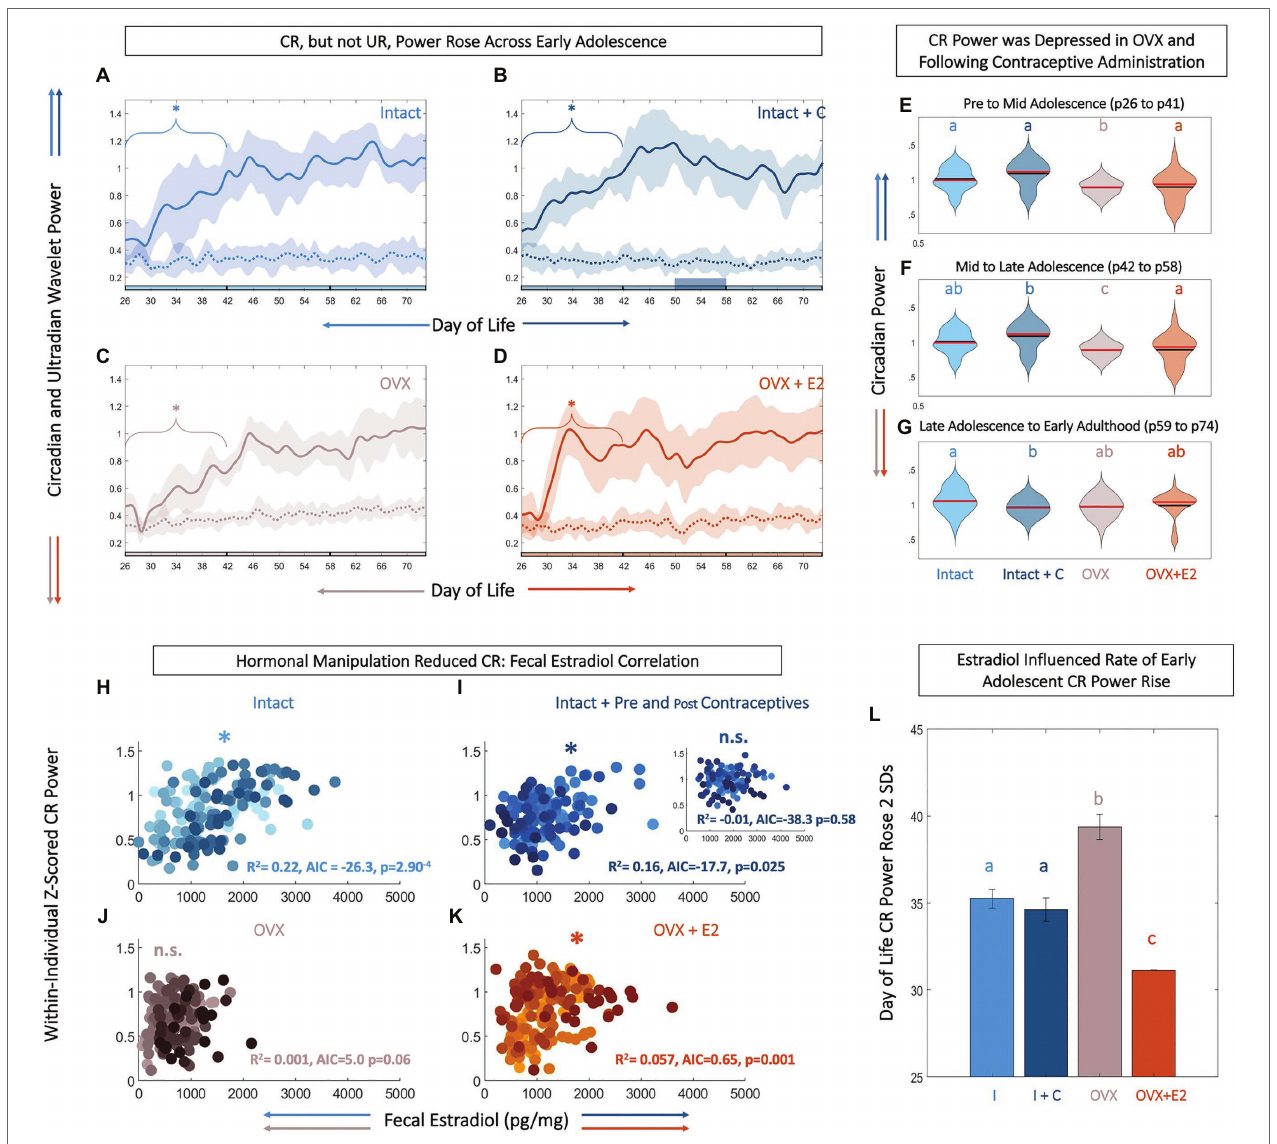
FIGURE 2 | Level and rate of early adolescent rise in core body temperature (CBT) circadian power are tied to fecal estradiol (fE2). Circadian, but not ultradian power rises across early adolescence (A-D) . Linear plots of group mean (±SD) of CBT circadian (solid) and ultradian (dashed) power in Intact (light blue, A ), Intact + C (dark blue, B ), OVX (gray, C ), and OVX + E2 (orange, D ) animals. * indicates significant trend over time for the bracketed time region ( p < 0.05). Phase of adolescent time periods (pre to mid, mid to late, and late to adult) are indicated by black dividers in the colored x-axis at p42 and p58. Although, CBT circadian power rises over early adolescence in all groups, estradiol increases the rate of this rise (L) . Violin plots (E–G) of circadian power in each group analyzed by segment of life: pre to mid adolescence from p26 to p41 (E) , mid to late adolescence from p42 to p57 (F) , and late adolescence through early adulthood from p58 to p73 (G) illustrate that circadian rhythm (CR) power is highest in Intact animals, with a reduction following hormonal contraceptive administration and OVX, and a partial rescue in OVX + E2 animals. Black lines indicate mean and red lines indicate median of each plot. Scatters of fE2 level by CR power indicate that hormonal manipulation reduces or eliminates the correlation between CR power and fE2 concentrations (H-K) . Note that each individual within a group is plotted in a unique color. CR power and fE2 are significantly correlated in Intact (light blue, H ), Intact + C animals prior to contraceptive administration (dark blue, I ), with inset depicting abolished correlation during and after contraceptive administration. CR power and fE2 are weakly correlated in OVX + E2 (orange, K ) but not OVX animals (J) . * indicates significant positive correlation between fE2 and CR power. AIC indicates relative performance of the mixed effects model. Color of letters at the top in E–G and L indicate experimental group; letters indicate statistical differences, with groups not sharing the same letter being significantly different ( p <